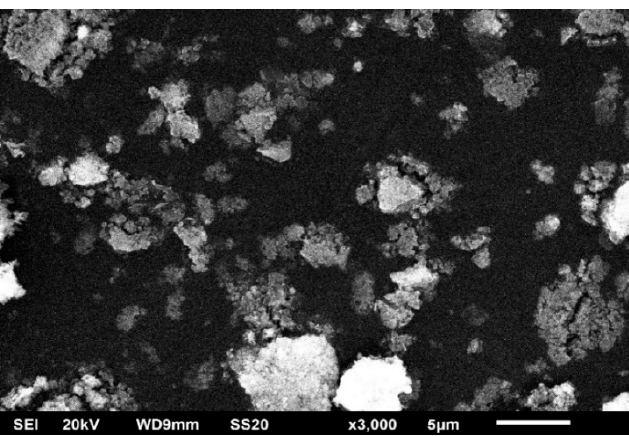
ammonia complexes; labelled peaks at 2.09, 1.81, and 1.28 attributed to Cu 0 (ASTM 4-0836).